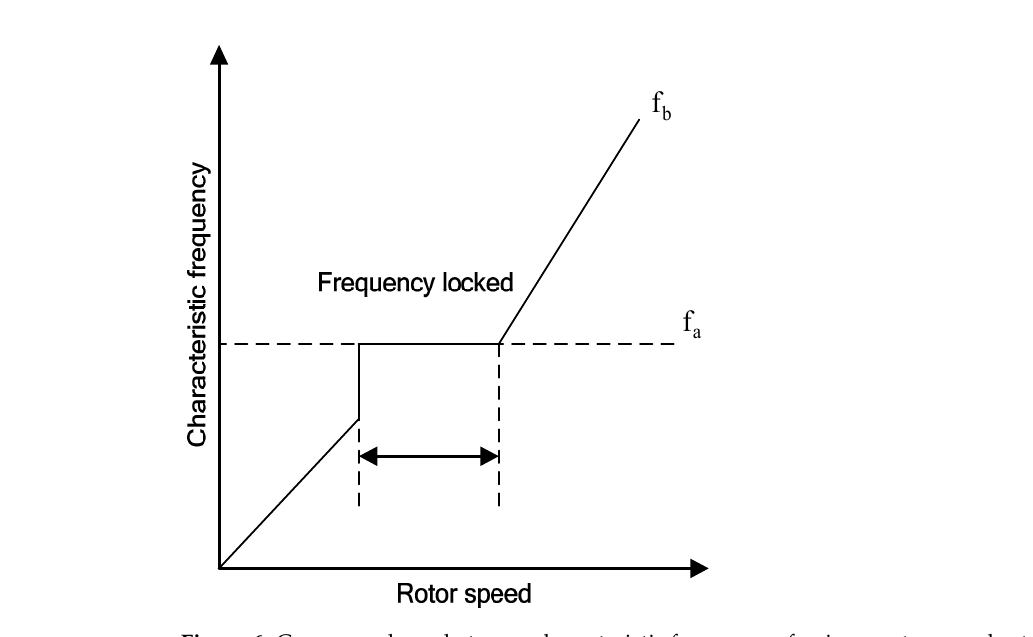
Figure 6. Correspondence between characteristic frequency of noise spectrum and rotor speed.